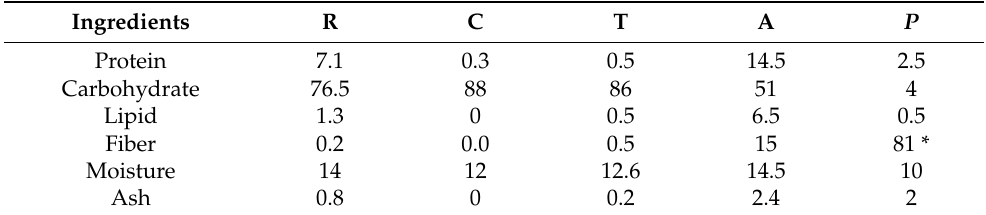
Table 1. Proximate chemical and nutritional composition of gluten-free ingredients (g per 100 g ingredient, as is). Ingredients R